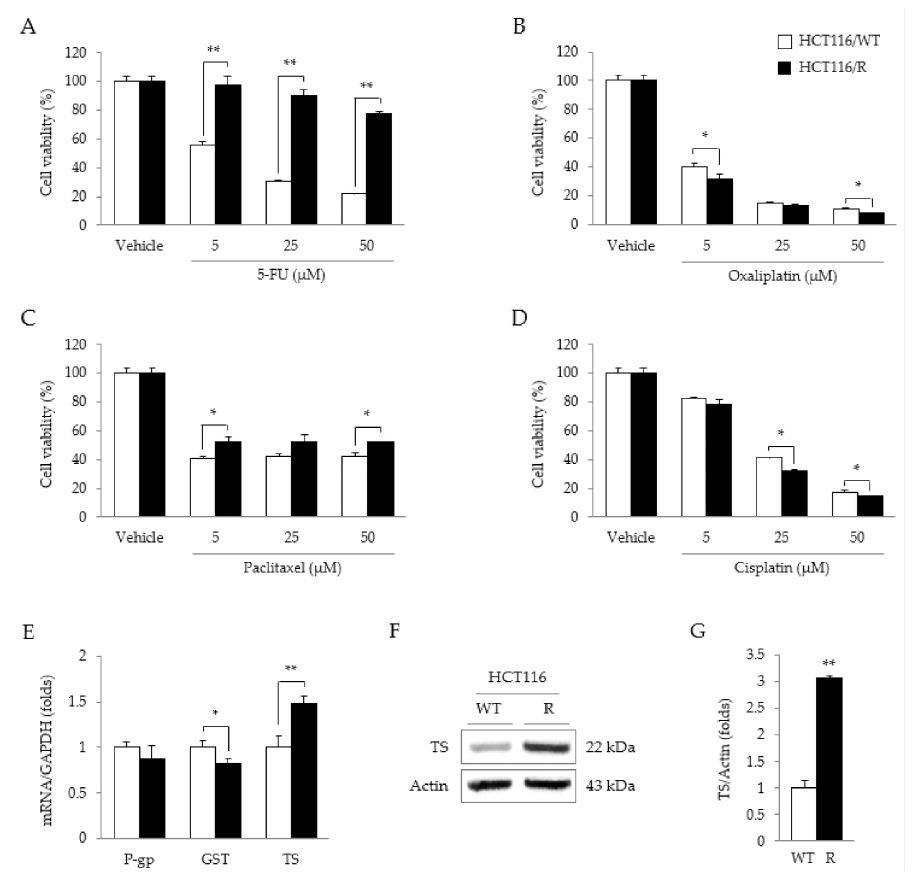
Figure 2. 5-FU specific resistance is mediated by TS overexpression. Cell viability was measured to investigate anticancer drug resistance against 5-FU ( A ), oxaliplatin ( B ), paclitaxel ( C ), and cisplatin ( D ), in both HCT116/WT and HCT116/R cells. Gene expression levels of P-gp, GST, and TS were analyzed in HCT116/WT and HCT116/R cells ( E ). Protein expression levels ( F ) of TS and their quantitative comparisons ( G ) between HCT116/WT and HCT116/R cells were analyzed. Data are expressed as the mean ± SD ( n = 3) values. * p < 0.05 and ** p < 0.01, as compared to the vehicle-treated cells or the corresponding parental